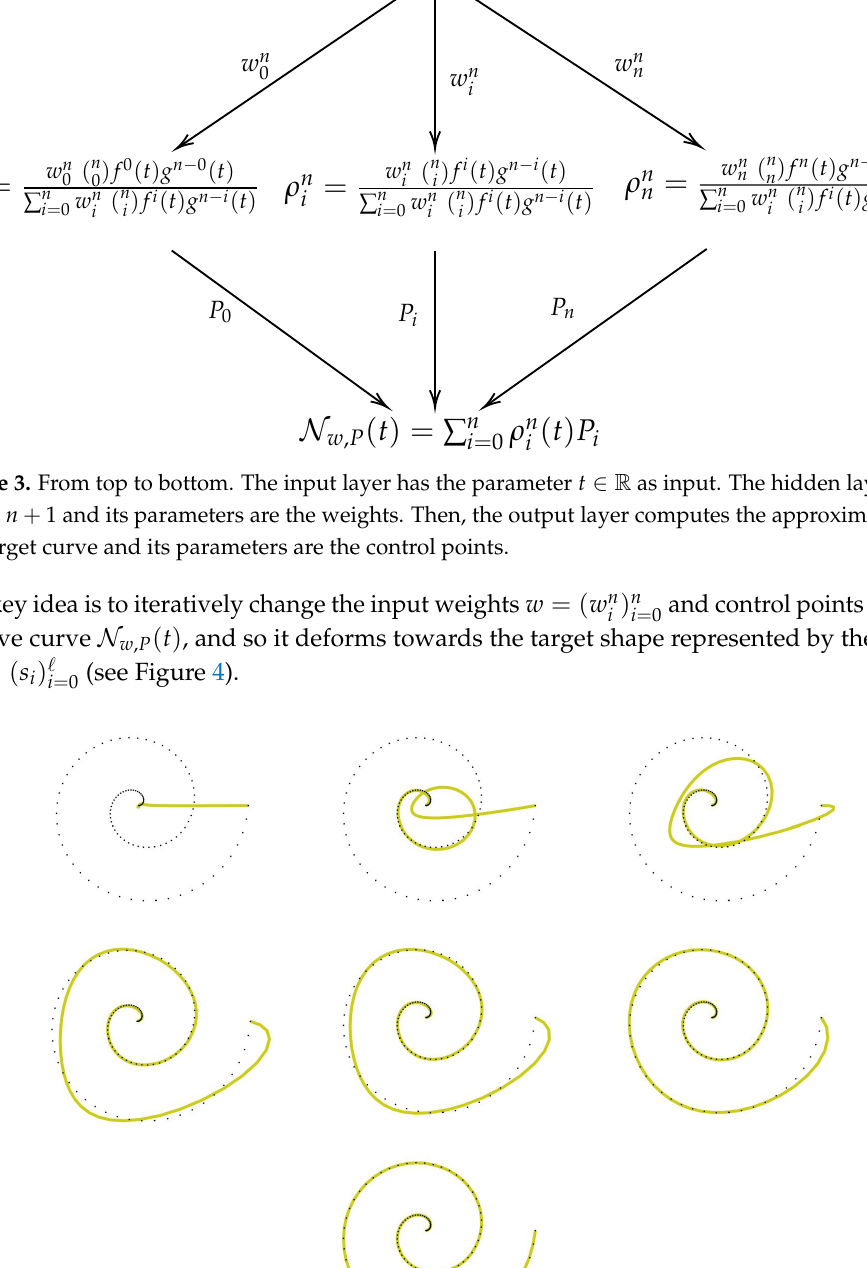
Figure 3. The obtained curve N w , P ( t ) is the rational curve c ( t ) that approximates the given set of data points and we denote as the fitting curve.